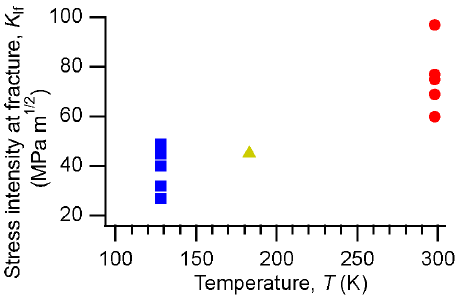
Figure 1. Loss of toughness with decreasing temperature in Zr 57 Ti 5 Cu 20 Ni 8 Al 10 .